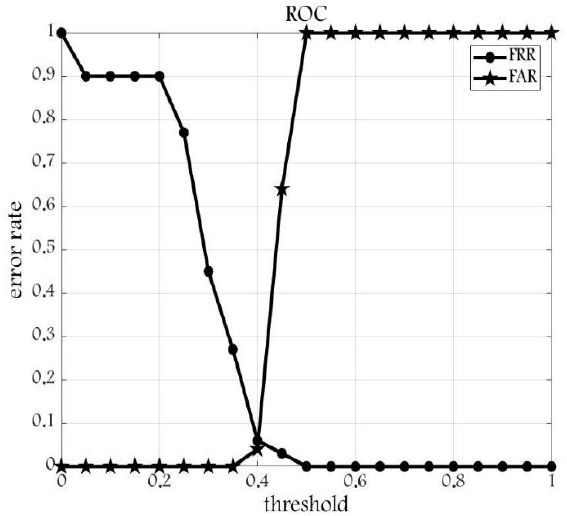
Figure 12. Curve ROC relateds to proposed method.